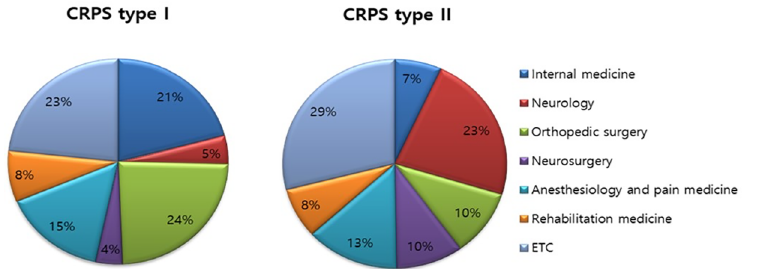
Fig 7. Medical specialty associated with the management of patients with CRPS in 2015.